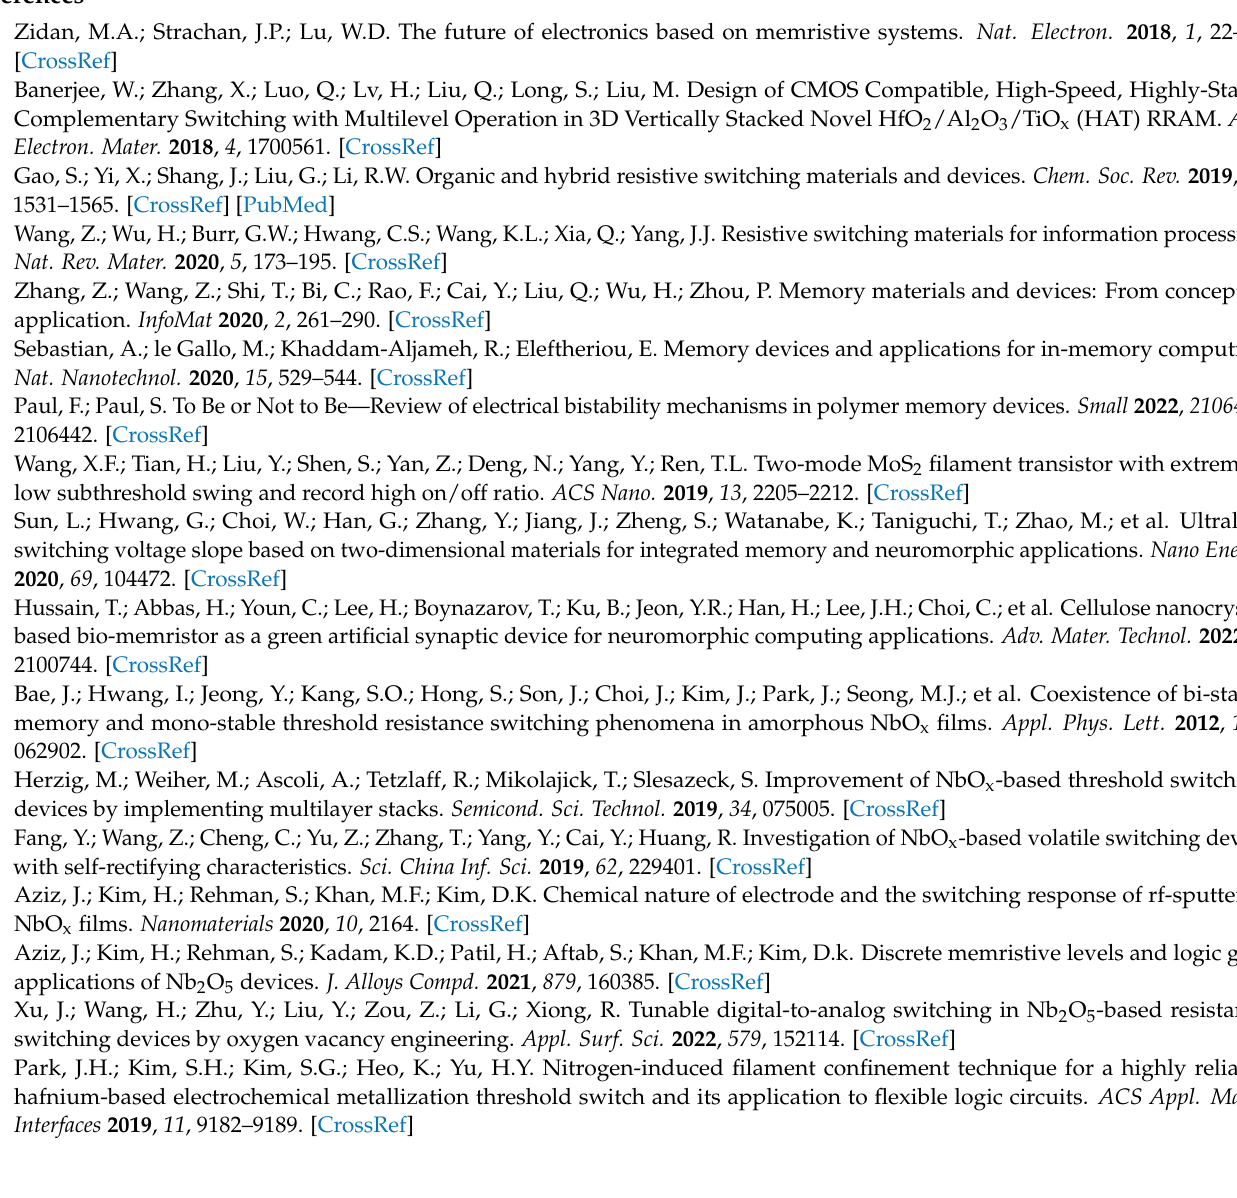
Standard error values of fitting parameters and the fitting degree R 2 of the equation in Figure